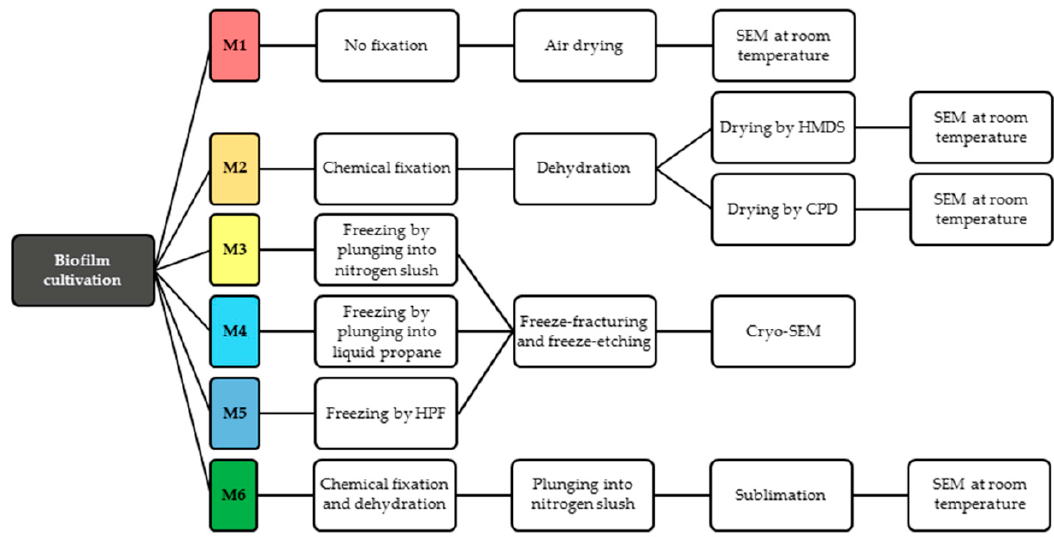
Figure 1. Diagram of microbial biofilm sample preparation for SEM.